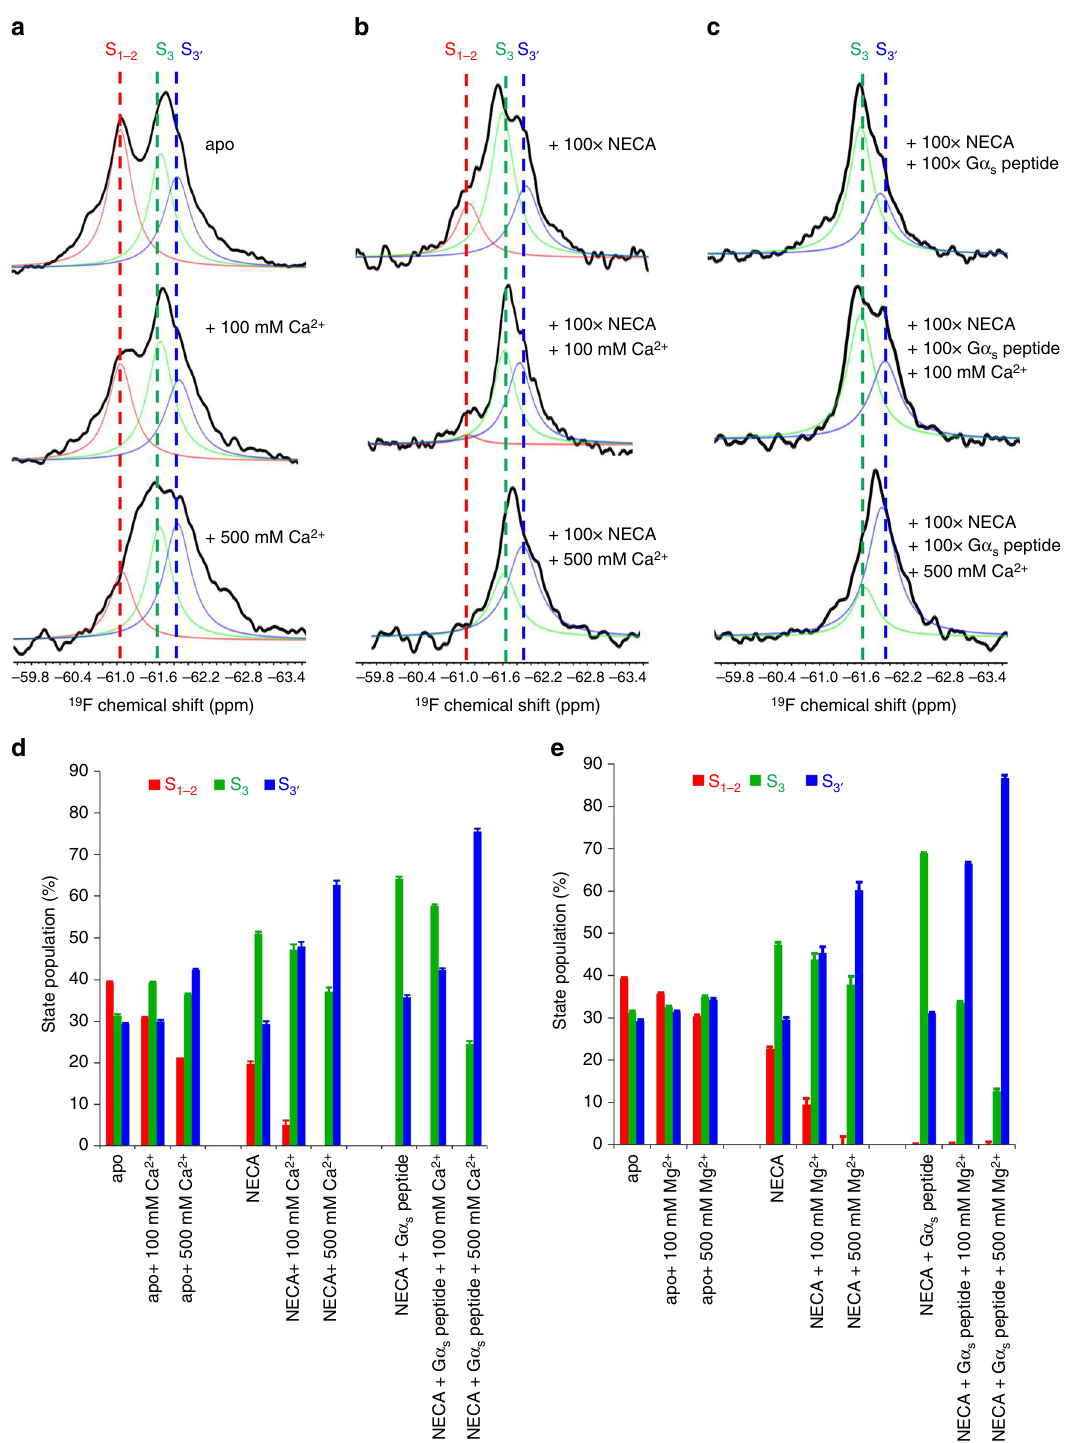
Fig. 3 Comparison of the effects of divalent cations Ca 2 + and Mg 2 + on the receptor. a 19 F NMR spectra of 100 μ M apo BTFMA-labeled A 2A R-V229C as a function of Ca 2 + concentration (0, 100, and 500 mM CaCl 2 ). b 19 F NMR spectra of 100 μ M NECA-saturated BTFMA-labeled A 2A R-V229C as a function of Ca 2 + concentration (0, 100, and 500 mM CaCl 2 ). c 19 F NMR spectra of both NECA- and G α s peptide-saturated BTFMA-labeled A 2A R-V229C as a function of Ca 2 + concentration (0, 100, and 500 mM CaCl 2 ). d Population histogram of states, S 1 − 2 , S 3 and S 3 ′ , upon titration of different concentrations of CaCl 2 , in combination with saturating NECA and G α s peptide. e Population histogram of states, S 1 − 2 , S 3 and S 3 ′ , upon titration of different concentrations of MgCl 2 , in combination with saturating NECA and G α s peptide (refer to Supplementary Fig. 2 for corresponding 19 F NMR spectra). NECA and G α s peptide were used in 100× excess over the receptor. All samples contained 100 mM Na